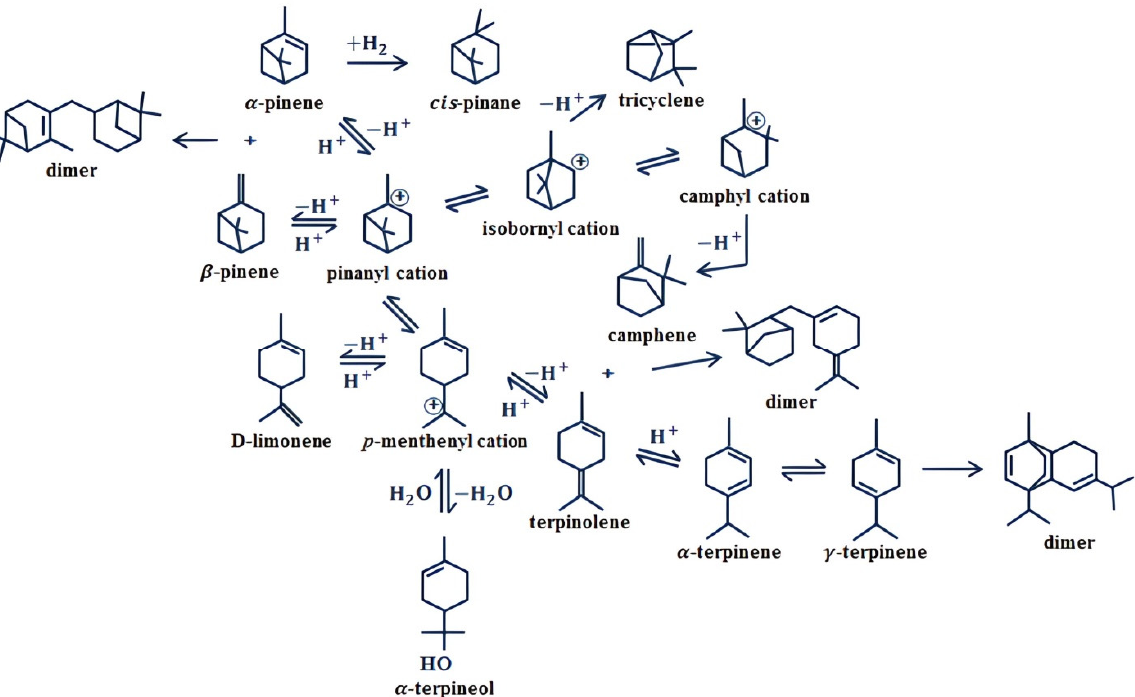
Figure 5. Reaction pathway scheme for the transformation of α -pinene and β -pinene based on acid catalysis.